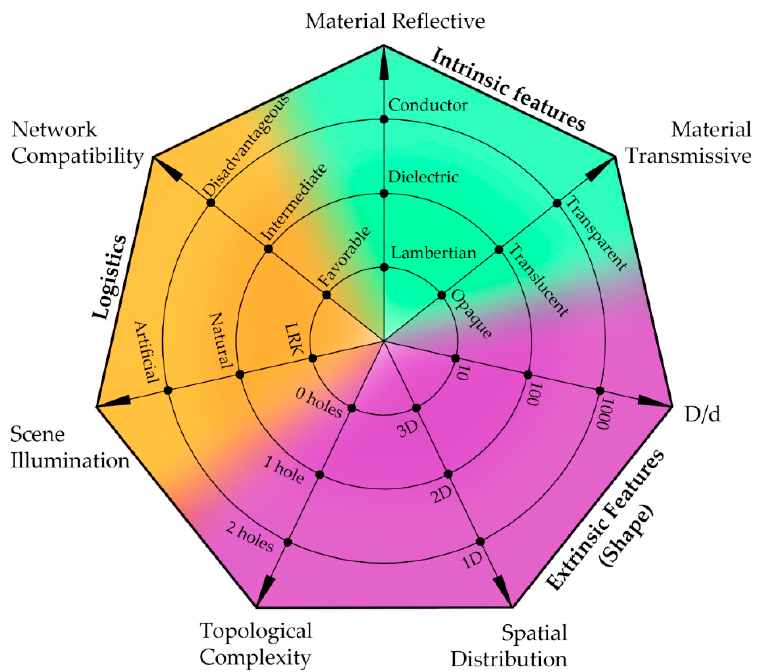
Figure 19. General features ( D/d ratio ; Spatial distribution ; Topological complexity , etc.) of micro-/meso-scale objects belonging to museum collections. Table 2. Features evaluation of collection pieces.